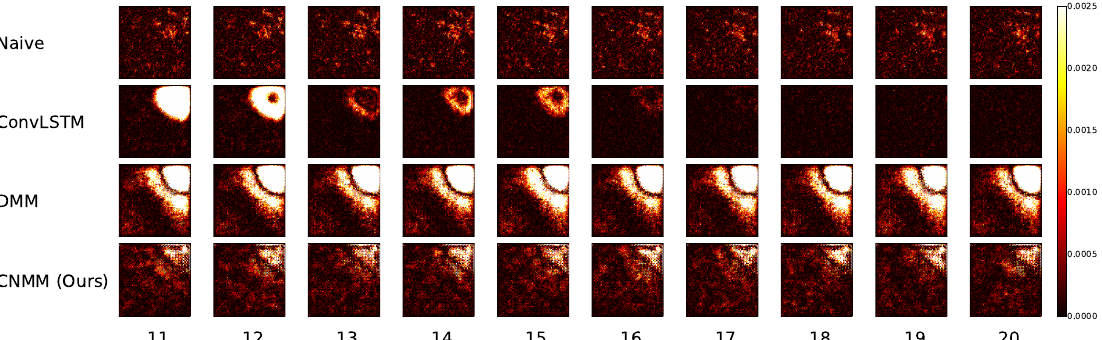
Figure 8. Squared error heatmap between ground truth and predicted forecast of the upper-left data used in the plot shown in Figure 6 (2D heat equation data). Higher errors are shown by the bright regions. Here, we can see the initial high prediction error in the area of heat on ConvLSTM’s forecasts, correlating with the high prediction error shown by Figure